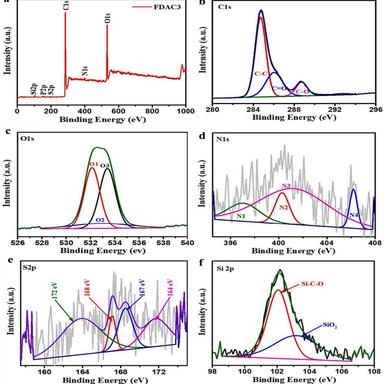
XPS spectra of FDAC3, the XPS survey (a), XPS scan and fitting peaks of C 1s (b), O 1s (c), N 1s (d), S 2p (e), and Si 2p (f).